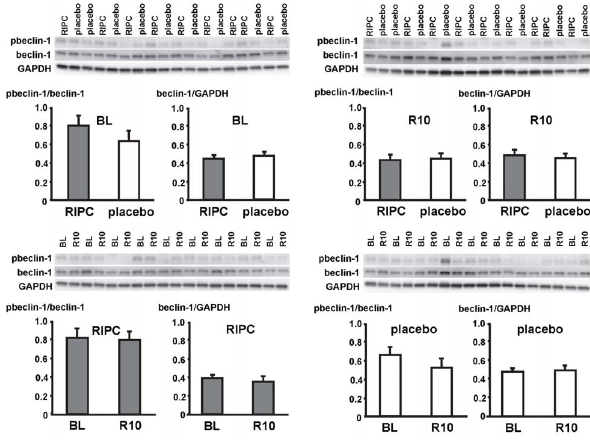
Figure 3. Phosphorylation and expression of beclin-1. Original Western blots of protein content of phosphorylated (p) and total beclin- 1 in myocardial biopsies obtained at baseline (BL) before initiation of cardiopulmonary bypass and at 5–10 min reperfusion (R10) from patients undergoing remote ischemic preconditioning (RIPC) or not (placebo). Immunoreactivity of pbeclin-1 was normalized to the respective total protein. Immunoreactivity of total protein was normalized to glyceraldehyde 3-phosphate dehydrogenase (GAPDH). Ratios are presented in bar graphs.